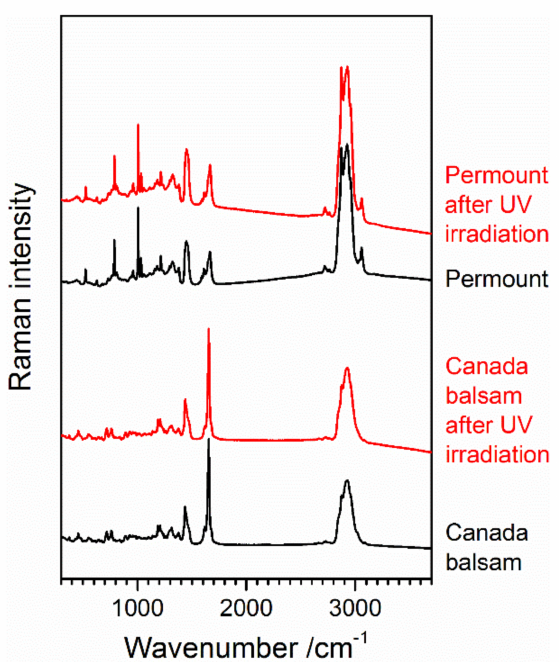
Figure 10. Raman spectra of Canada balsam and Permount TM before and after exposure to UV